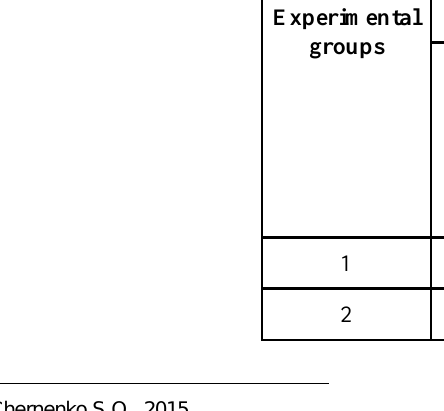
Matrix of 2 3 type factorial experiment in studying of different modes of exercise’s repetitions for level of its mastering Experimental